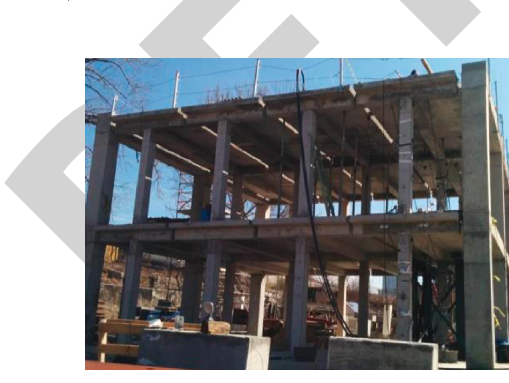
Figure 3: Four separate frames.